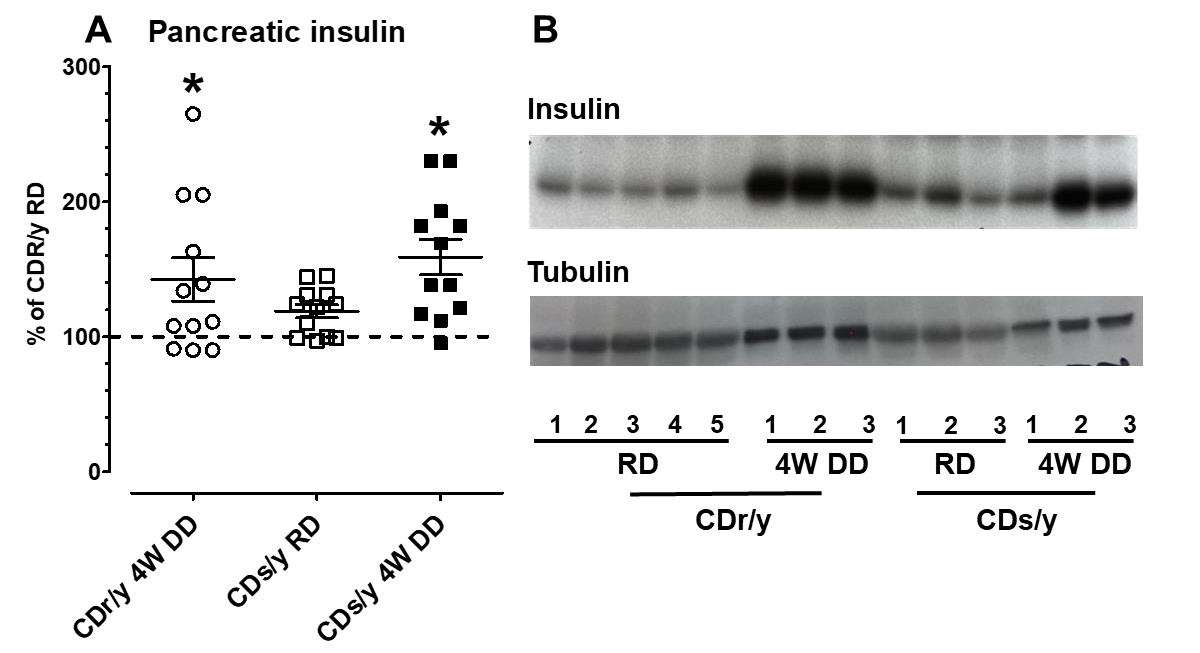
Figure 6. Panel ( A ) – pancreatic insulin content by Western blot and densitometry in CDr/y provided RD ( n = 10), in CDr/y provided DD over 4 weeks (open circles, n = 12), in CDs/y provided RD (open squares, n = 12) and in CDs provided DD for 4 weeks (closed squares, n = 12). The dotted horizontal line represents the average of ten animals, assayed as five duplicates and serving as reference in each gel to standardize for between gel-variations in densitometry readings. * p < 0.01 compared to CDr/y RD by one way ANOVA and post-hoc LSD testing. Panel ( B )-representative Western blot of insulin in each group and tubulin which served as the internal protein control. For CDr/y RD, we used ten animals pooled in five duplicates (labeled 1 – 5); for CDr/y DD, CDs/y RD, and CDs/y DD, we loaded on each gel protein extracts from three animals in each group (labeled 1 – 3).